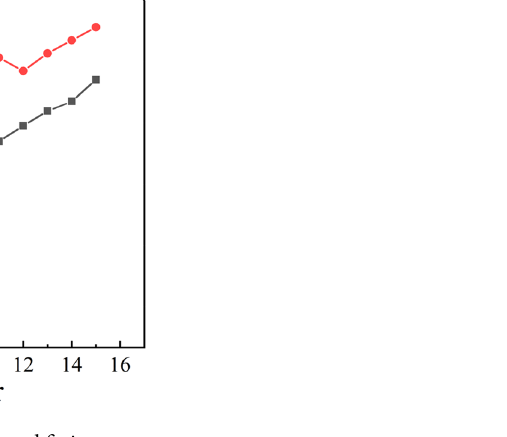
Figure 24. Comparison of experiment and